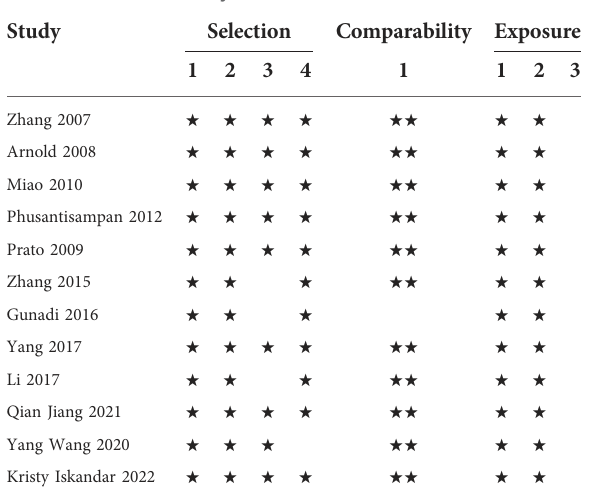
Sensitivity analysis calculates the overall correlation coef fi cient obtained by removing a group of studied data respectively, and then quanti fi es the difference between each correlation coef fi cient to obtain the stability of the whole data and the model. The robustness of the meta-analysis was assessed by comparing the results of analyses before and after the removal of one study. The processed results were not signi fi cantly different from the previous results, thus the data and model have high robustness ( Figure 3 ).